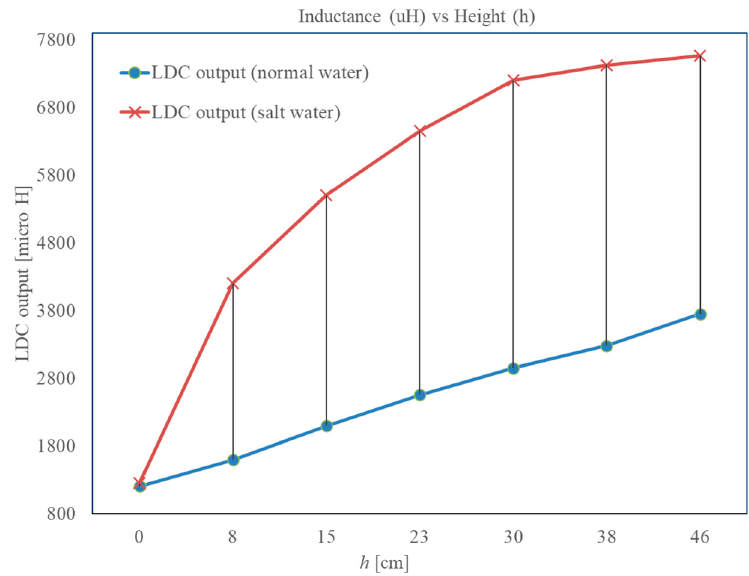
Figure 8. Output of the LDC for good water and salty/relatively conductive water.